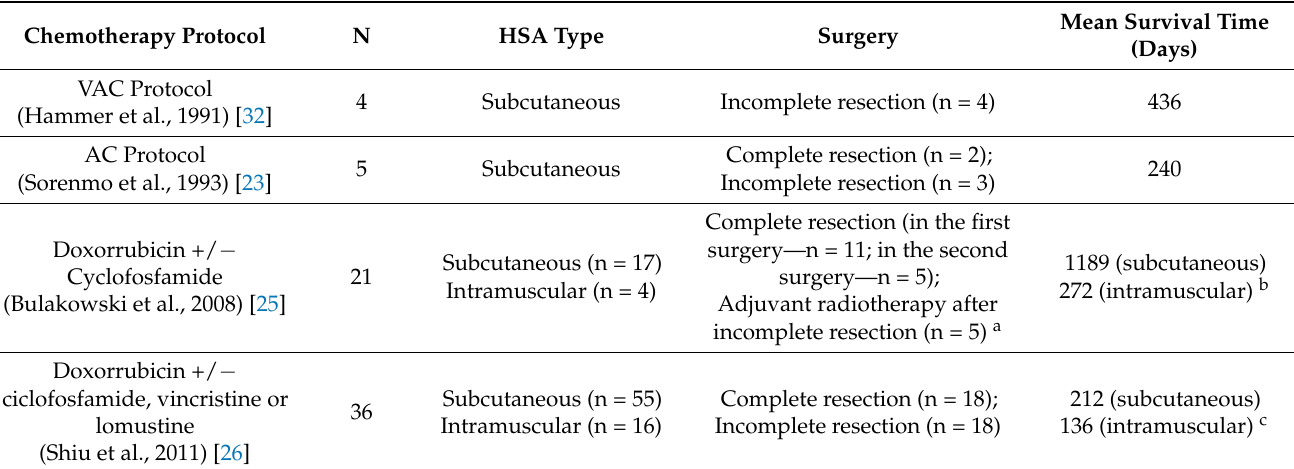
Table 2. Chemotherapy protocols evaluated in canine subcutaneous and intramuscular HSA, type of surgery, and median